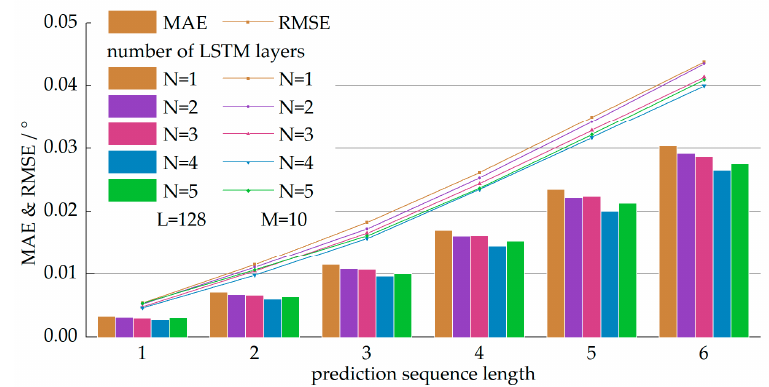
Figure 6. Performance of the models with a different number of hidden LSTM layers where L = 128, M = 10. The horizontal axis denotes the prediction sequence length. The vertical axis denotes the value of the MAE and RMSE. The bars represent the value of the MAE and the solid lines represent the value of the RMSE.